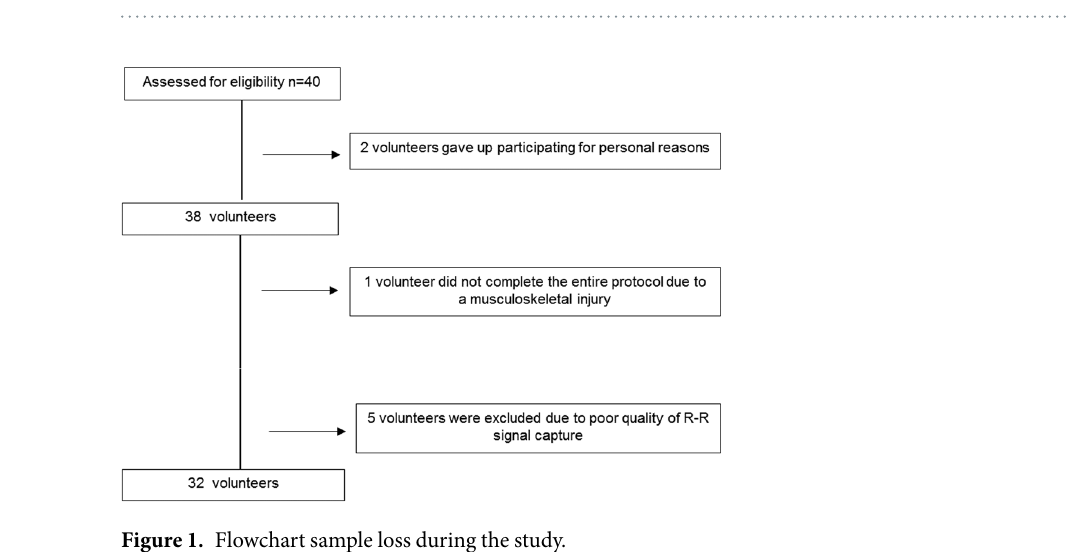
Table 1. Mean values, followed by their respective standard deviations, minimum and maximum values of the anthropometric variables and the cardiopulmonary exercise testing. SD = standard deviation; BMI = body mass index; kg = kilogram; m = meter; VO 2 peak = peak oxygen consumption; ml = milliliter; min = minutes; HR = heart rate; bpm = beats per minute.